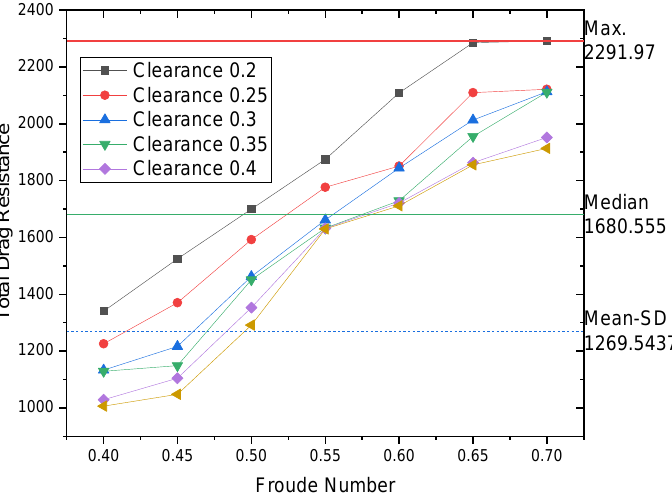
Figure 11. Total drag vs. Froude number by clearance factor.